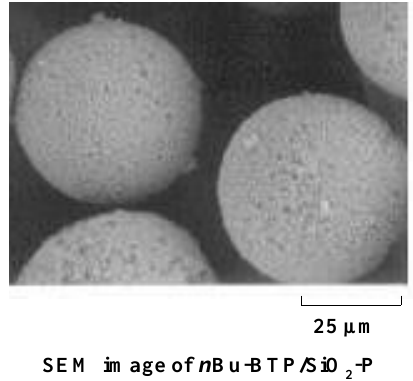
Figure 2. Structure and photograph of the n Bu-BTP/SiO 2 -P adsorbent.